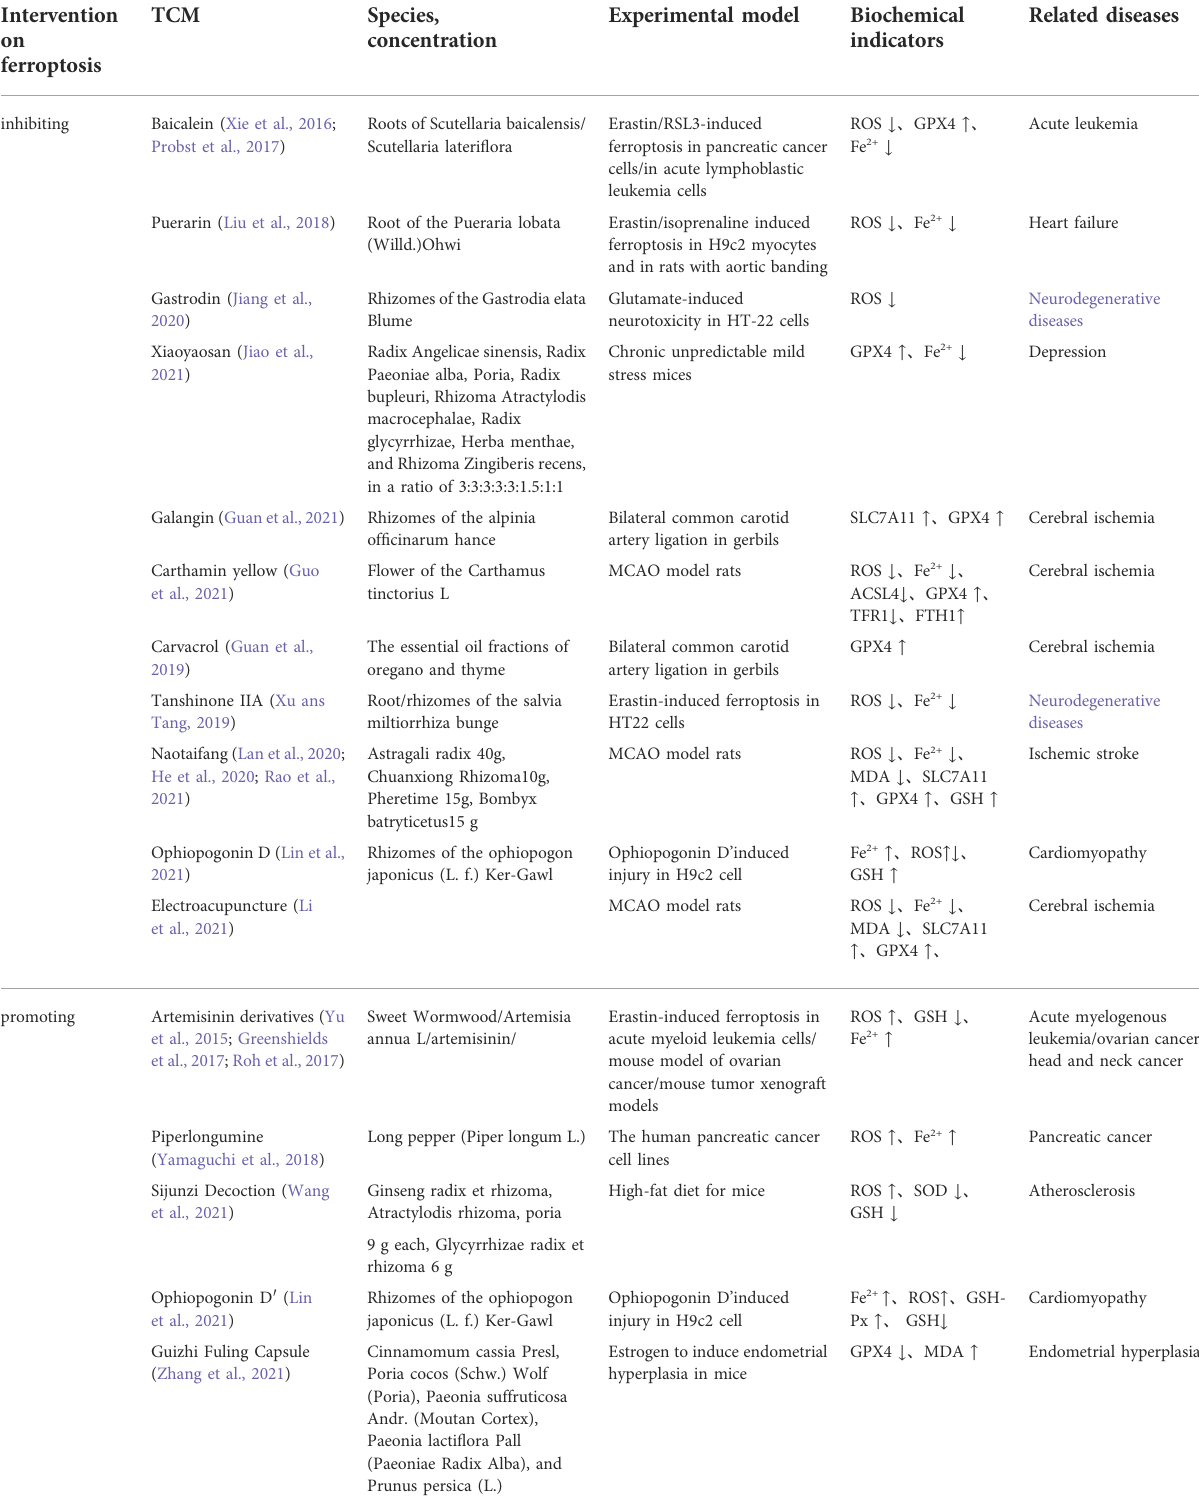
TABLE 1 TCM targeted intervention ferroptosis to alleviate diseases. Intervention on